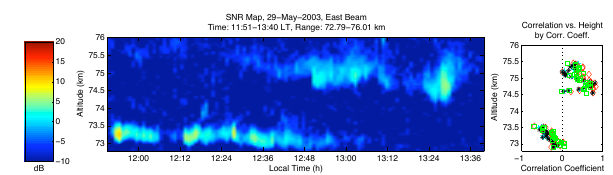
Fig. 10. Two thin structures at 73.2 and 75 km on May 29 starting at 11:50 and 12:50 LT, respectively.